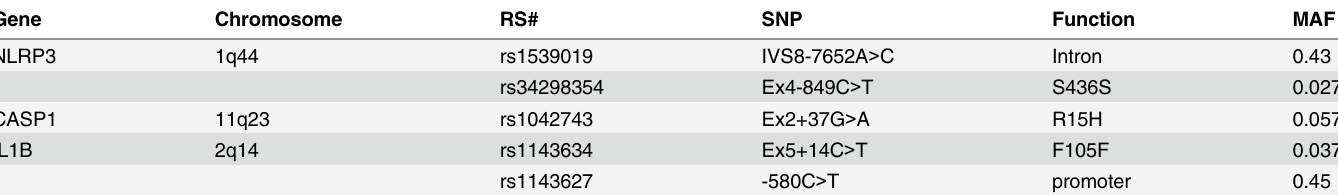
Table 1. Summary of the single nucleotide polymorphisms(SNPs) among the 3 candidate genes. Gene